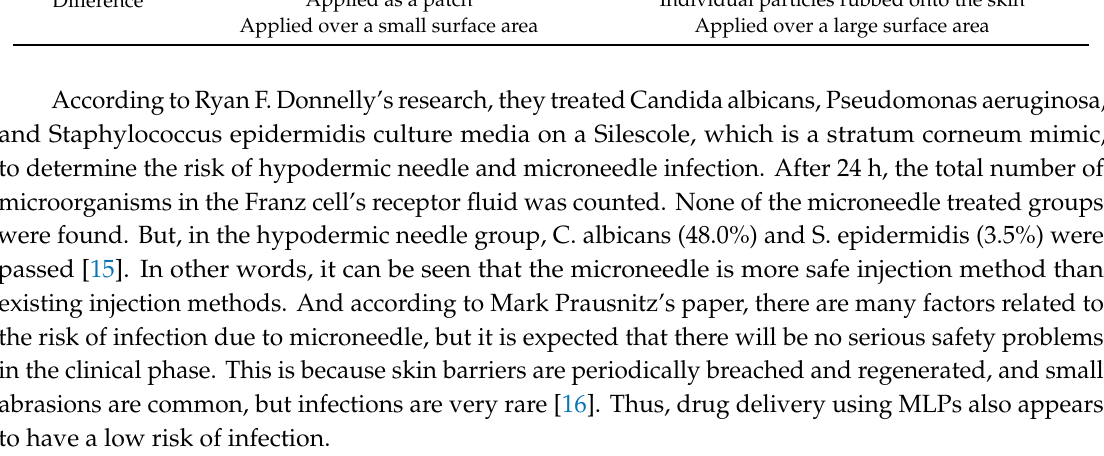
Table 1. Similarities and di ff erences between MLPs and conventional microneedles. Type Similarity